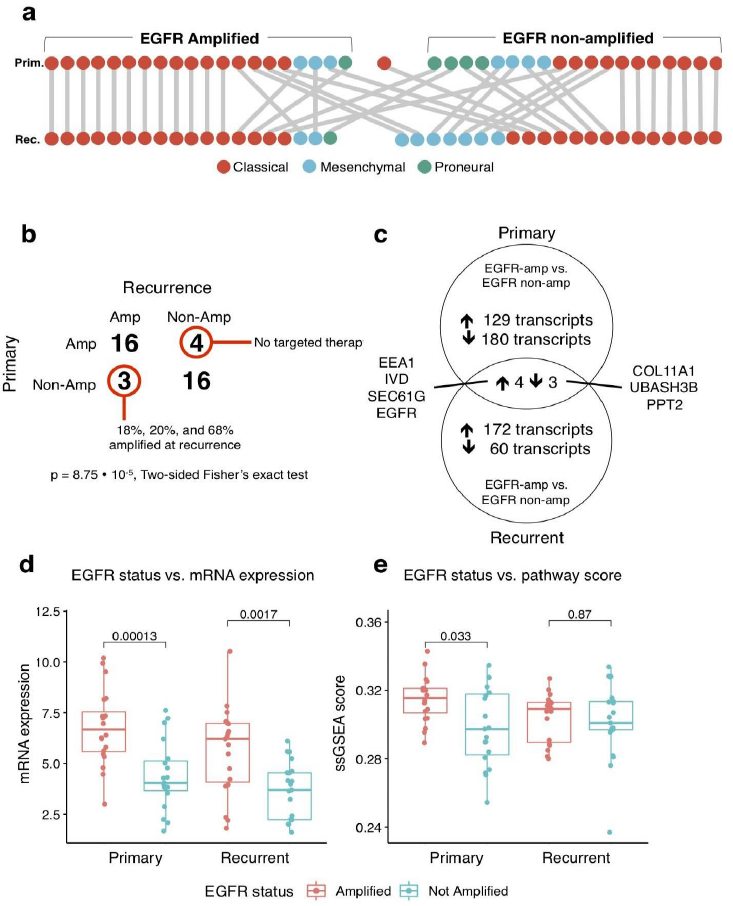
Figure 2. Overview of differences identified between EGFR-amplified and non-amplified tumours. ( a ) Schematic describing the changes in molecular subtype of each tumour between primary and recurrence, separated by EGFR amplification status. The singular primary tumour that is in neither group had indeterminate EGFR amplification status. ( b ) Two-by-two interaction table describing the relationship between EGFR amplification status in the primary tumour and recurrent tumour. ( c ) Differentially expressed transcripts between EGFR-amplified and non-amplified tumours in both primary (top circle) and recurrent tumours (bottom circle). Genes in common, either increased (left) or decreased (right) in EGFR-amplified tumours are listed in the centre of the diagram. ( d ) Box plots of EGFR mRNA expression (normalised, batch-corrected) with IQR boxed and median denoted by horizontal line, versus EGFR amplification status in the primary or recurrent tumour; p value is denoted by two-sided Wilcoxon rank sum test. ( e ) Analogous box plots describing EGFR gene signature score versus EGFR amplification status in primary and recurrent tumours.